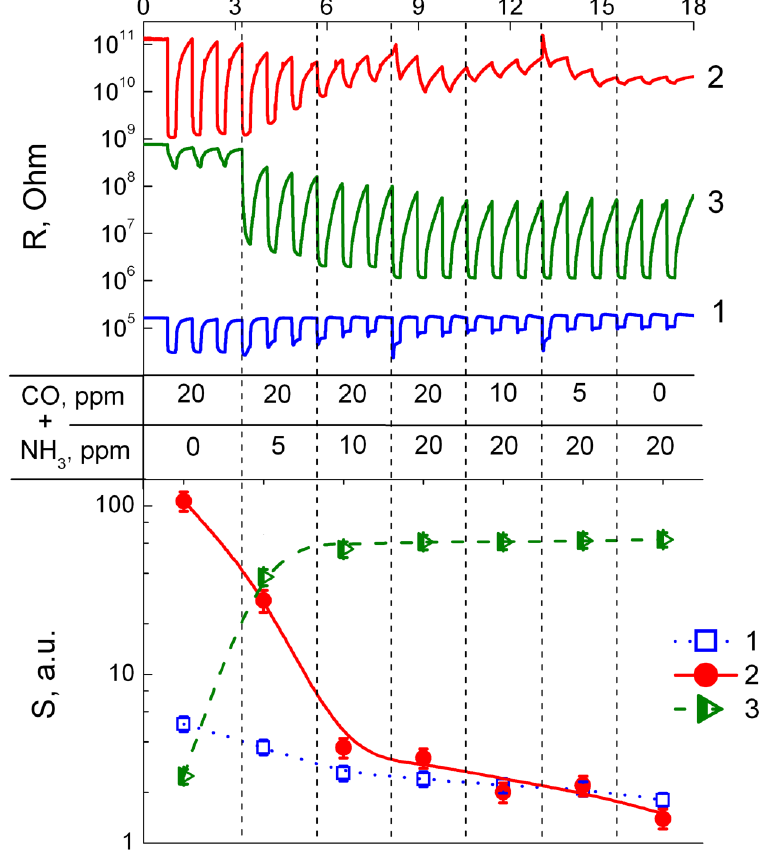
Figure 7. Upper plot: dynamic resistance response of SnO 2 (1), SnO 2 /PdO x (2), and SnO 2 /RuO y (3) sensors to the pulses of CO + NH 3 mixtures in air. The component concentrations in the test gas mixture are shown in the middle table. Operating temperature of sensors: SnO 2 —250 °C, SnO 2 /PdO x —50 °C, SnO 2 /RuO y —200 °C. Lower plot: corresponding sensor signals to the test gas